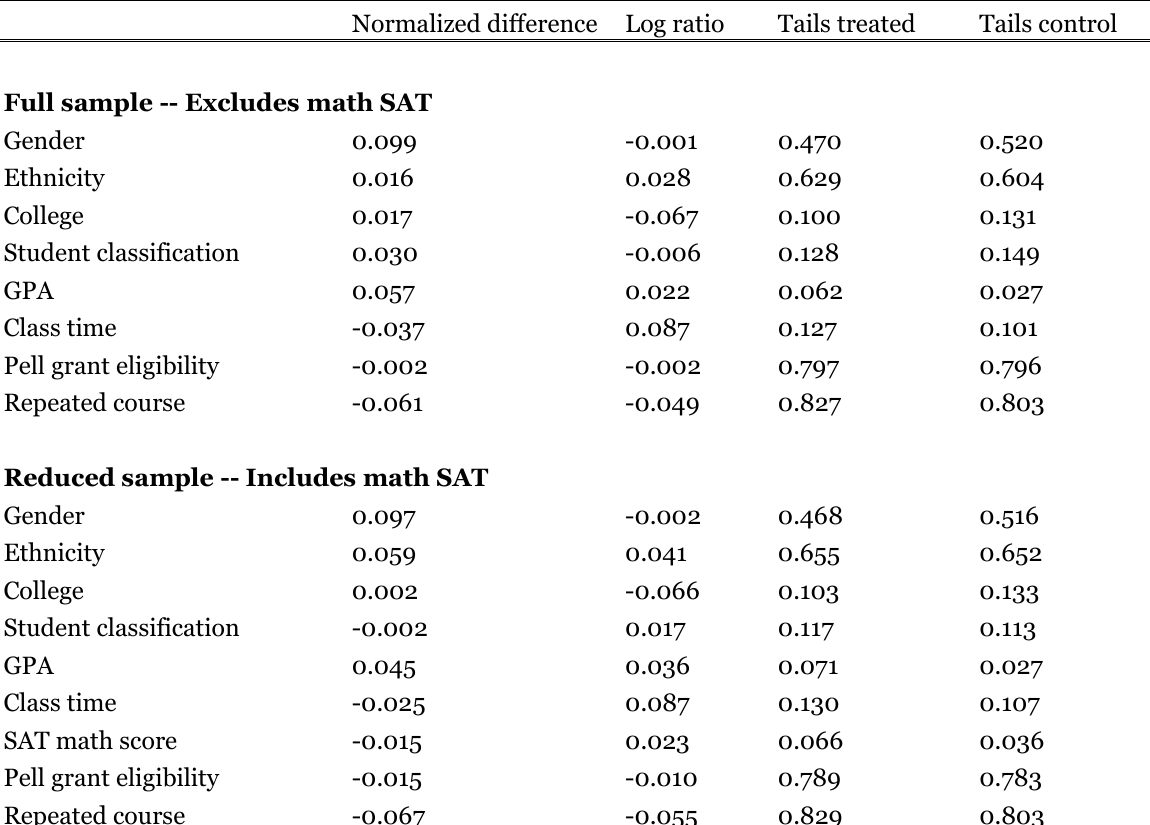
Pre-Match Balance and Overlap Assessment Between Fall 2014 and Fall 2015 Normalized difference Log ratio Tails treated Tails